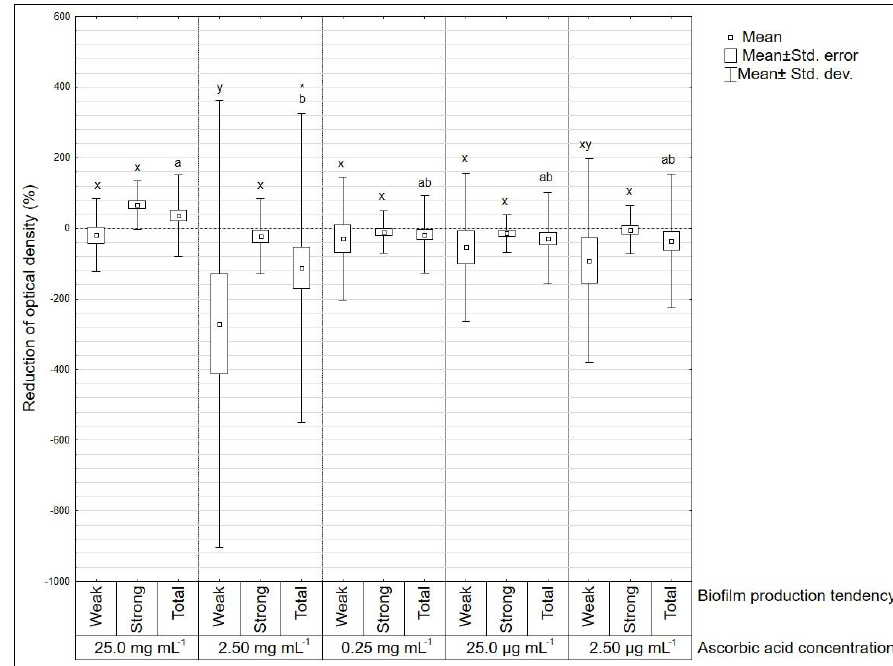
Figure 1. Reduction of optical density (%) after ascorbic acid treatment on Staphylococcus aureus ( n =